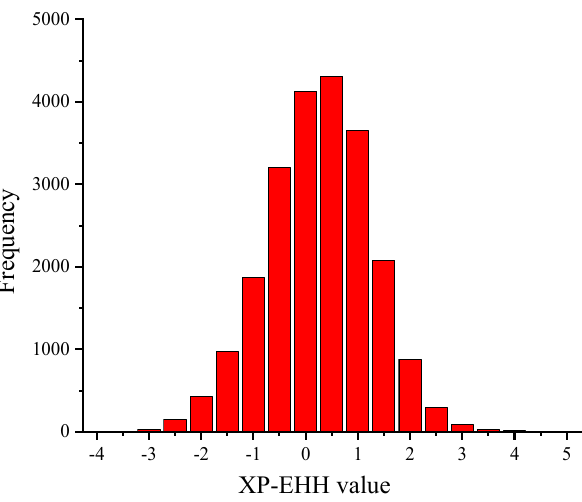
Figure 4. The distribution of XP-EHH in hair sheep and fine-wool sheep. The abscissa represents the haplotype value and the ordinate represents the number of occurrences of each region.